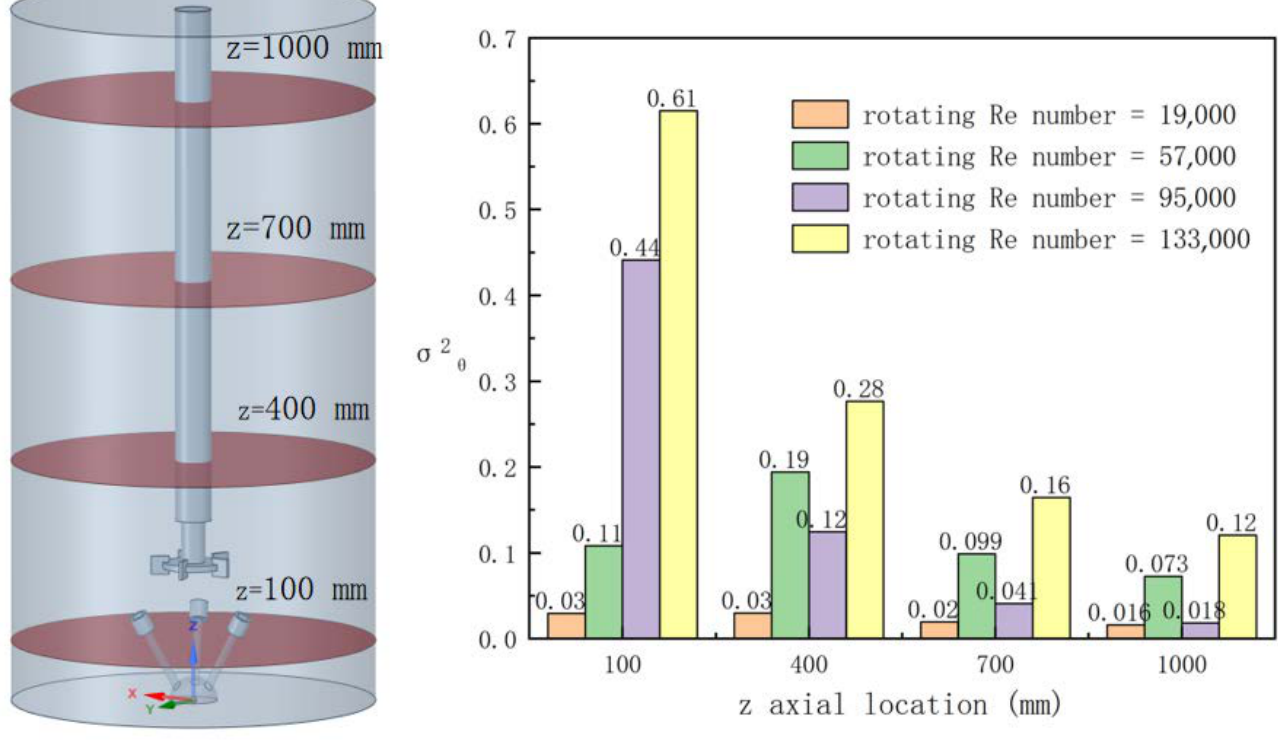
Figure 13. Variances under different rotation Reynolds